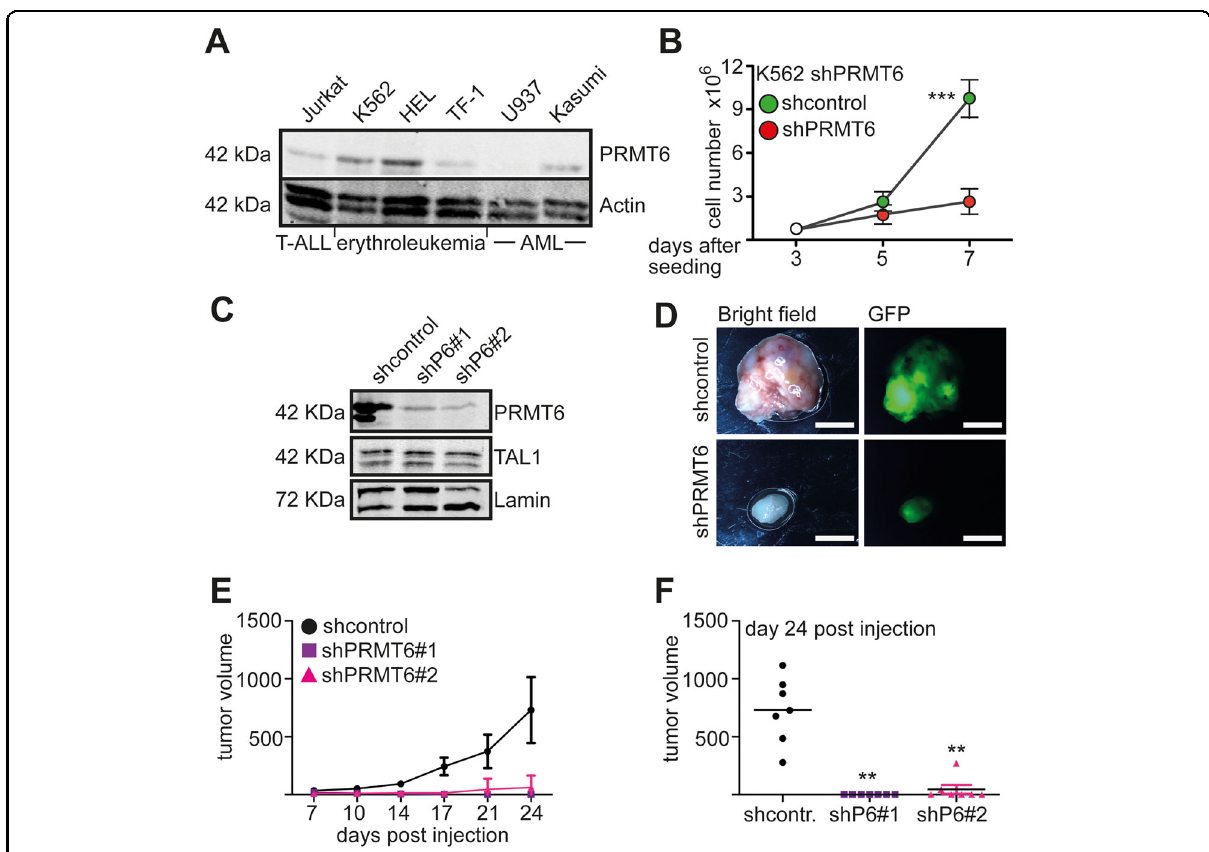
Fig. 1 PRMT6 knockdown decreases proliferation of hematopoietic cells lines. A Western blot analysis of PRMT6 expression in Jurkat, K562, HEL, TF-1, U937, and Kasumi cells. Western blot was done with extracts from the indicated cells and speci fi c antibodies against PRMT6. Lamin served as loading control. B PRMT6 mediates enhanced proliferation. PRMT6 was knocked down by shRNA in K562 cells. Six days after transduction shPRMT6 and shcontrol cells were seeded out in similar numbers. Cells were counted at the indicated time points. The error bars display the standard deviation from the mean from three determinations. The P -values were calculated using ANOVA. *** P < 0.001. C Western blot showing ef fi cient knockdown of PRMT6 with shRNA. Western blot against the transcription factor TAL1 and against actin served as controls. These cells were injected subcutaneously into C57BL/6 mice. D Analysis of subcutaneous tumors upon injection of shcontrol and shPRMT6 K562 cells, respectively. Bright fi eld and GFP image of an exemplary tumor from day 24 is displayed. The white bar indicates 0.5 cm. E Tumor growth curve from day 7 after injection until day 24 is shown for two shPRMT6 constructs. Tumor volume is given in mm 3 . F Endpoint analysis at day 24 of post-injection. Tumor volume is given. The P - values were calculated using ANOVA from seven mice. ** P < 0.01, *** P <